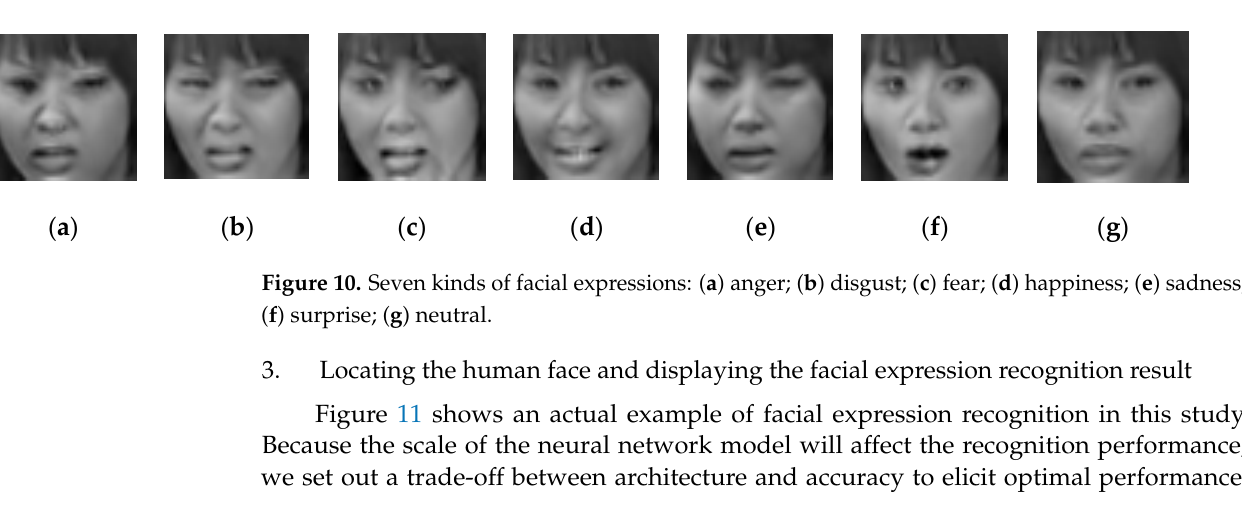
Figure 11. An example of facial expression recognition by our CNN model.